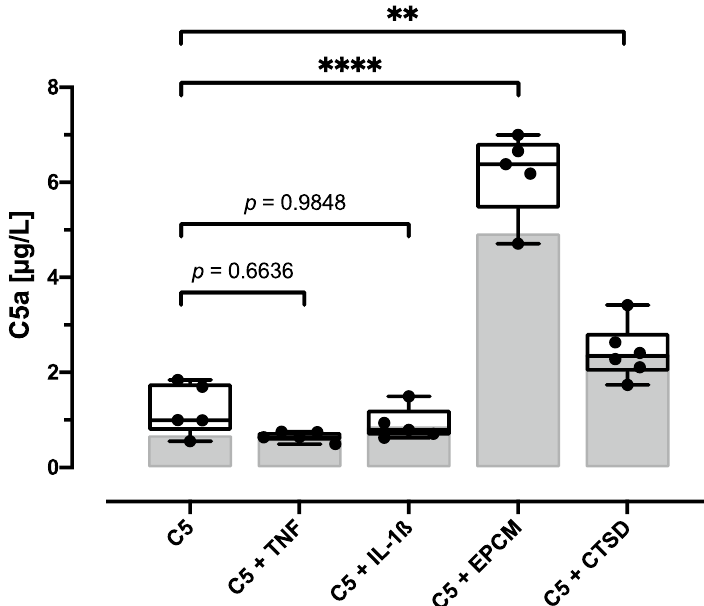
Figure 7. Analysis of C5 cleavage capacity. Quantification of C5a content in annulus fibrosus (AF) cell culture supernatants after 4 h cultivation in serum-free medium containing 20 µg/mL C5 only (C5) or supplemented with 10 ng/mL TNF (C5 + TNF), 10 ng/mL IL-1ß (C5 + IL-1ß), and 0.5 µg/mL CTSD (C5 + CTSD) as well as endplate-conditioned medium containing 20 µ g/mL C5 (C5 + EPCM). The